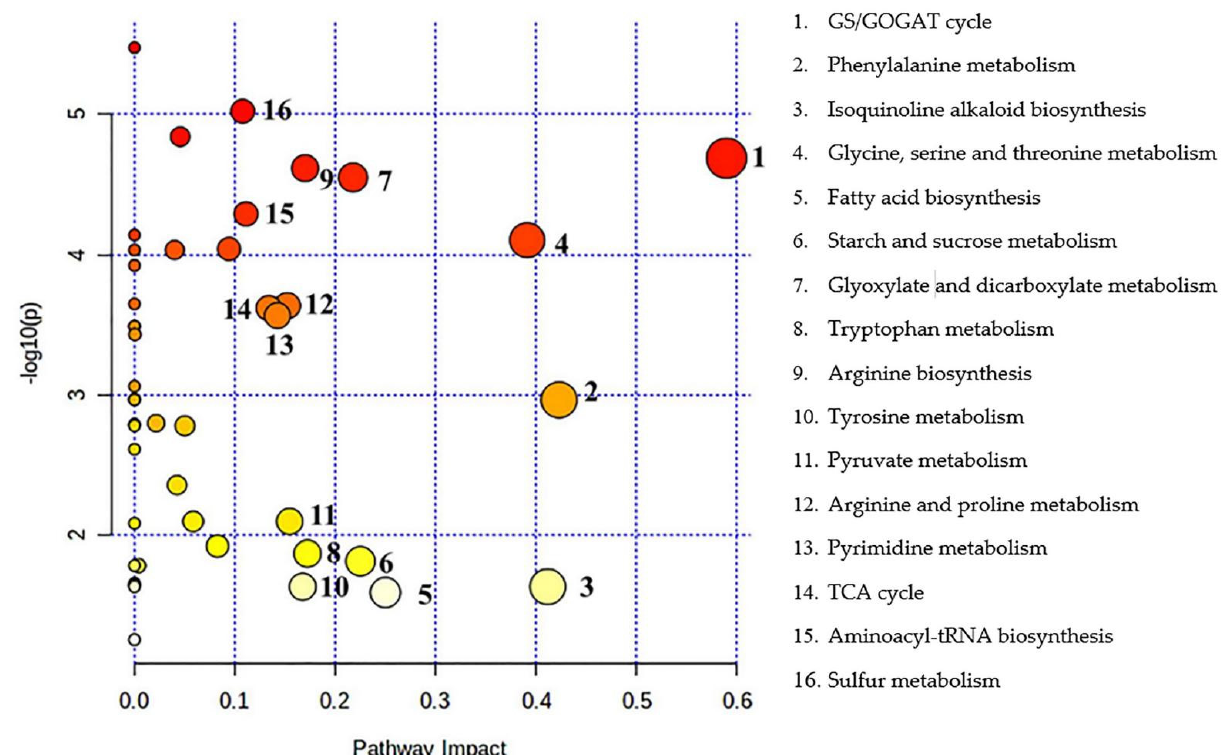
Figure 3. Enrichment analysis of metabolic pathways in L. chinensis seedlings. Circle color from shallow to deep represents p − value from large to small, circle. radius from small to large represents impact value from small to large. The deeper the circle color, the greater the radius represents the greater the impact of alkali stress on the pathway. The circle closer to the upper right corner of the pathway diagram represents the more significant effect of alkali stress on this metabolic pathway. Table 4. Pathway enrichment analysis depicting significantly altered metabolic pathways in L. chinensis in response to alkali stress.